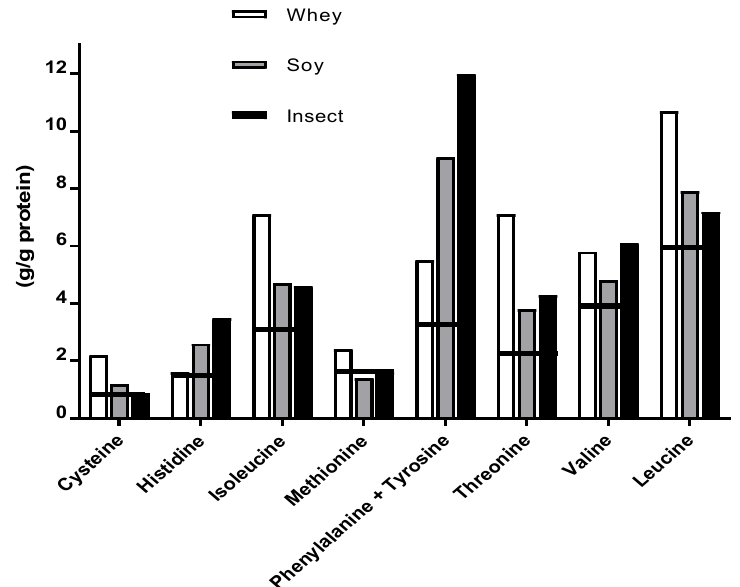
Figure 4. Amino acid content of pure protein shown in comparison to the FAO’s current adult requirement (horizontal lines). All values are presented as means, see Table